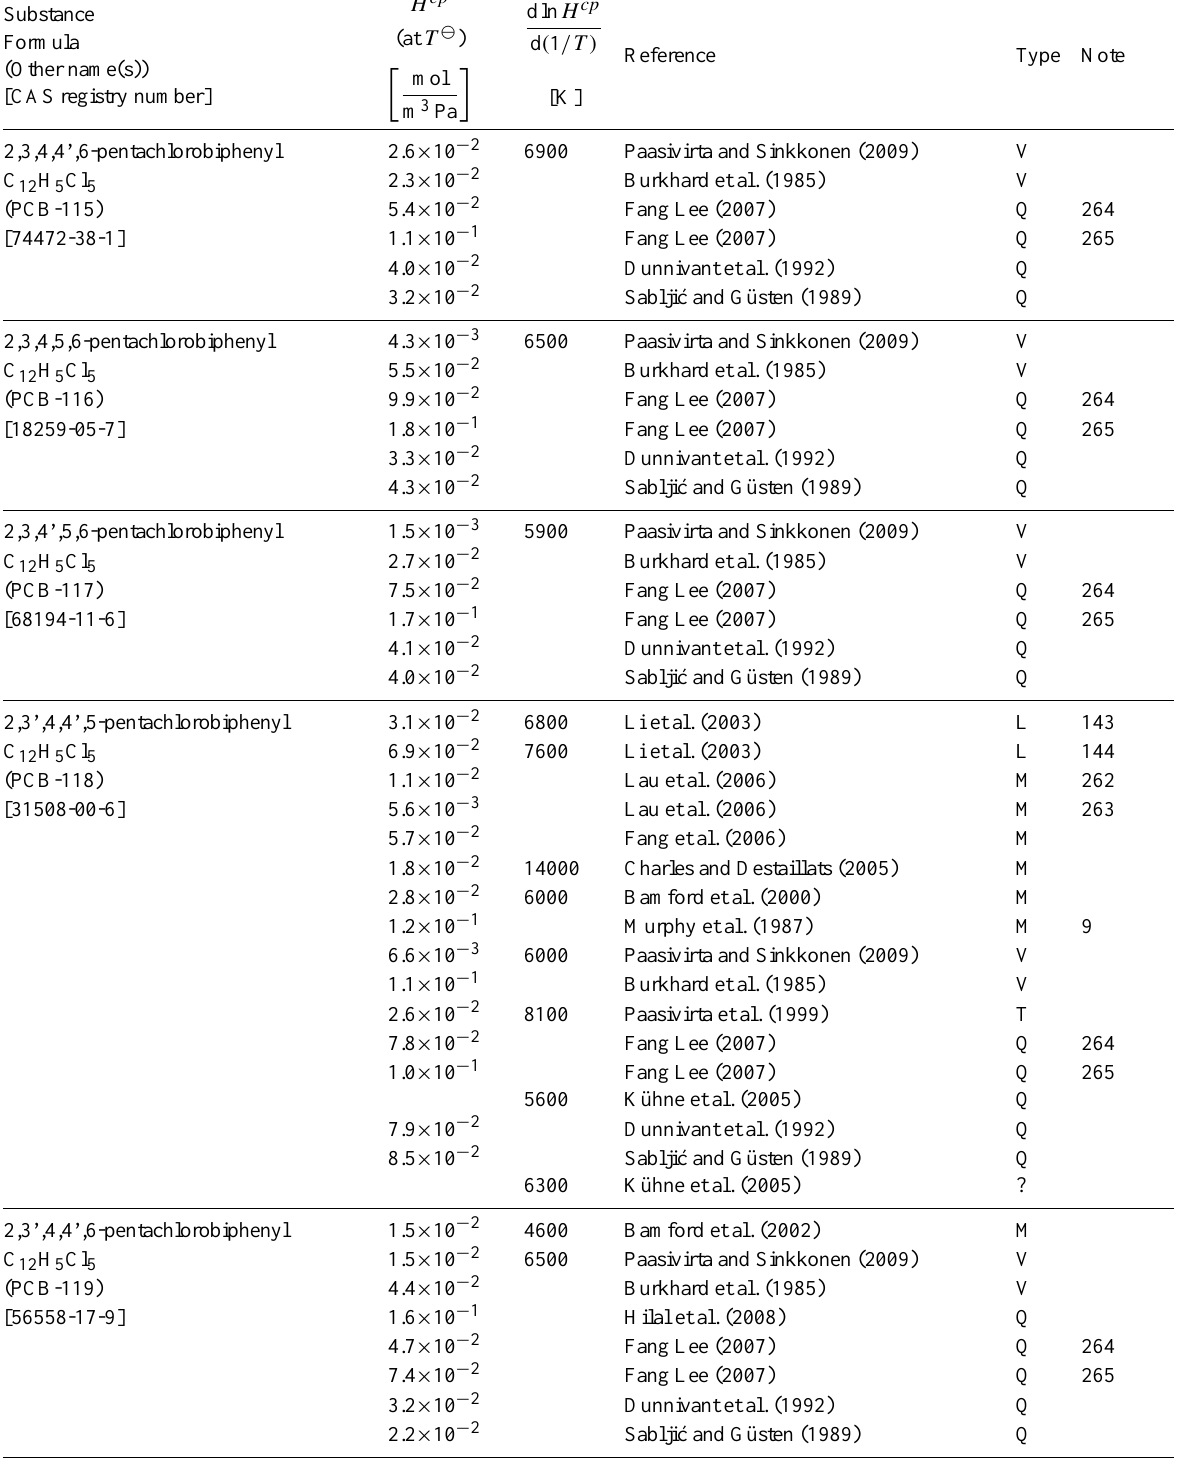
Table 6: Henry’s law constants for water as solvent